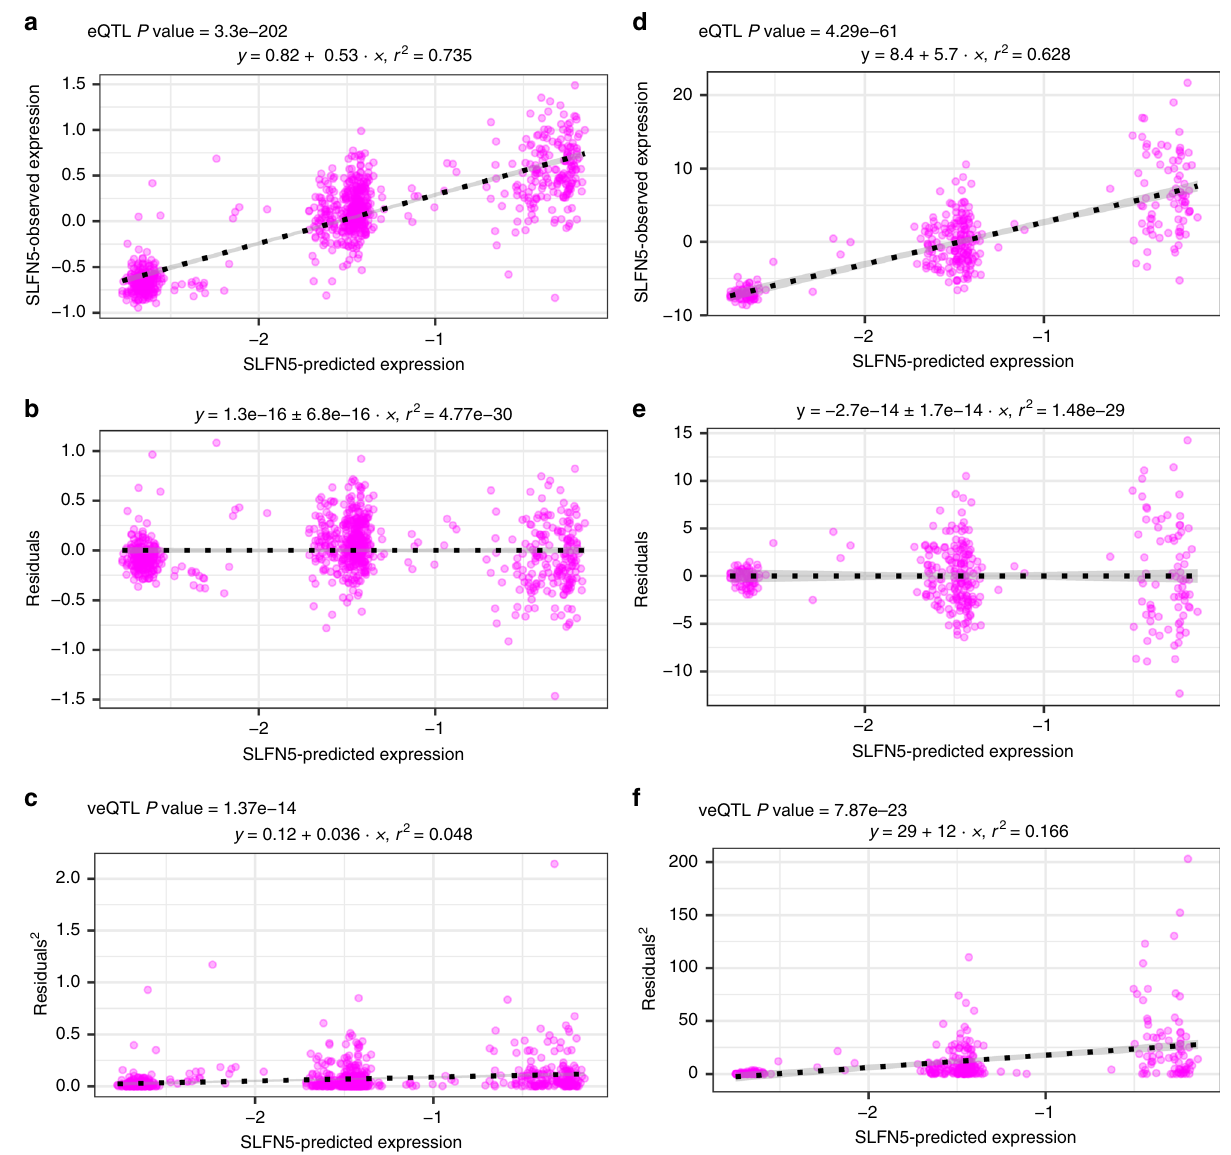
Fig. 4 Detecting regulatory variant-set veQTL. An example regulatory variant-set-based veQTL identi fi ed at the SLFN5 locus is shown. a SLFN5 shows a strong correlation between its predicted and observed expression levels in the Lothian Birth Cohort suggesting this gene is under the strong control of nearby regulatory variants. b Plotting the residual after regressing out this cis-eQTL effect against predicted expression levels suggests that this gene also shows set-dependent variance in expression. c Correlating the gene ’ s predicted expression level to the square of the residuals from b con fi rms the presence of a veQTL at this locus. d – f the same as a – c but resulting from analysis of the 1000 Genomes data. P -values derived from Spearman ’ s rho